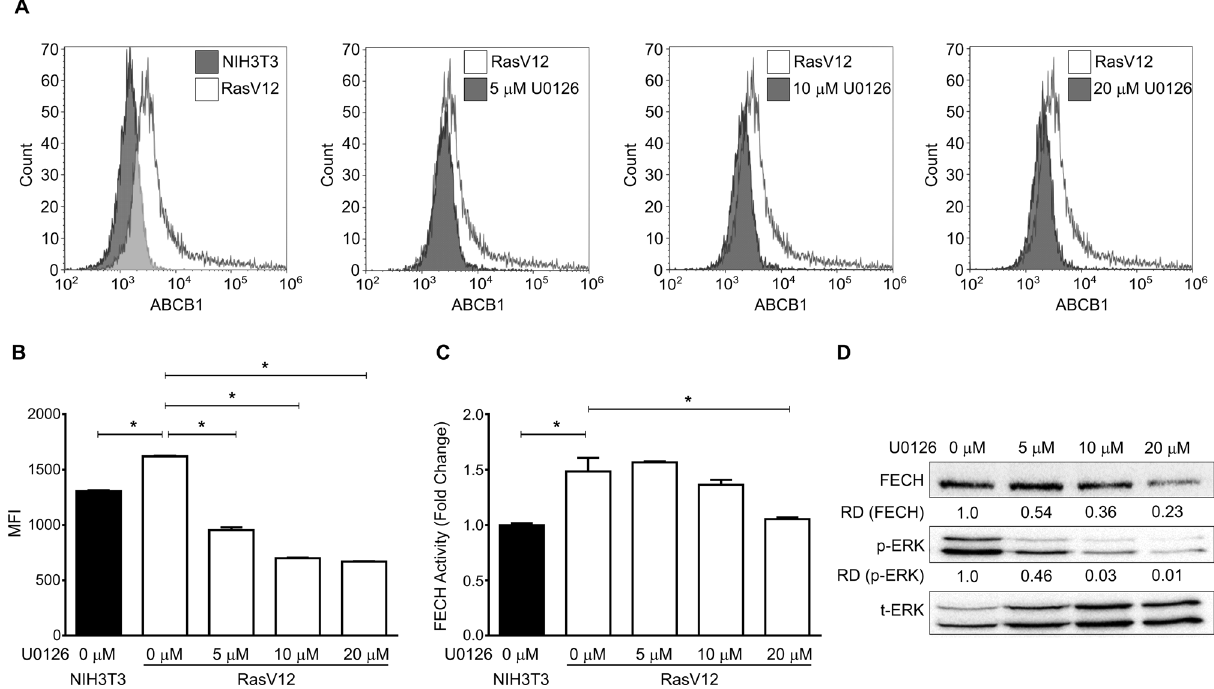
Figure 4. Oncogenic Ras/MEK regulates PpIX accumulation via ABCB1 and FECH. ( A ) Representative overlay histograms showing surface ABCB1 expression in NIH3T3 cells and RasV12 cells treated with or without different concentrations of MEK inhibitor, U0126. ( B ) Plot shows mean ± SD mean fluorescence intensity (MFI) from 3 independent experiments. ( C ) Mean ± SD relative FECH activity in NIH3T3 cells and RasV12 cells treated with or without different concentrations of U0126 from 3 independent experiments. ( D ) Representative western blot showing FECH expression and ERK phosphorylation levels in NIH3T3 and RasV12 cells treated with or without different concentrations of U0126. The relative band densities (RD) are indicated. *p < 0.01 by one-way ANOVA with Turkey’s posthoc